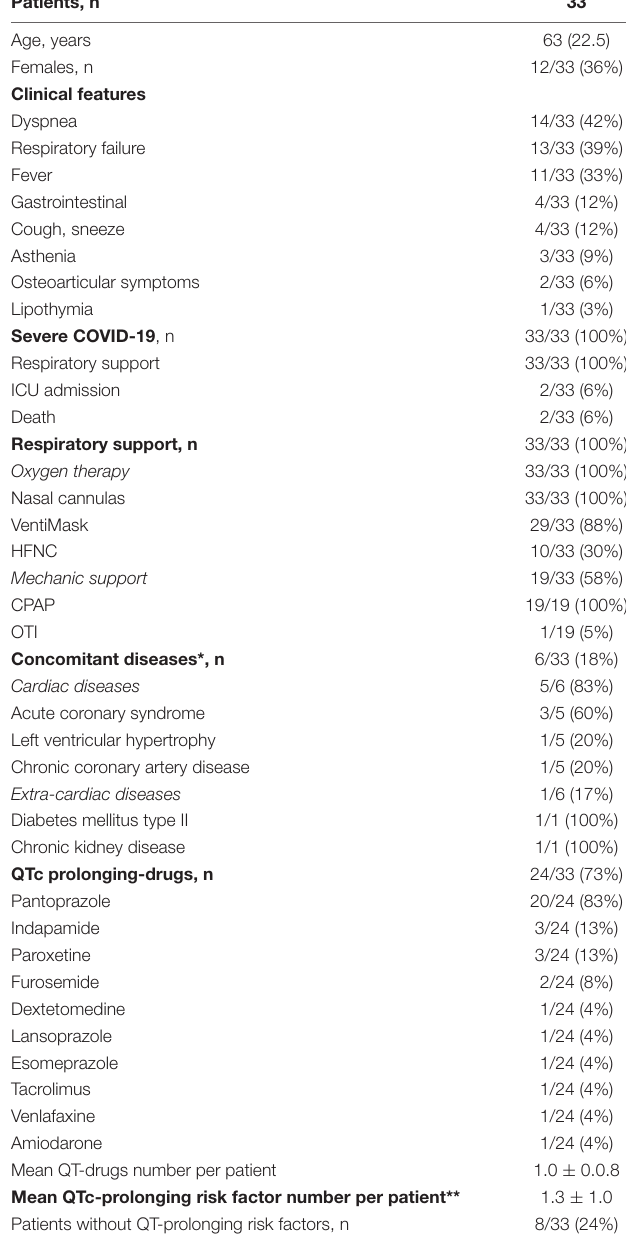
TABLE 1 | Demographic, clinical, and laboratory characteristics of patients with